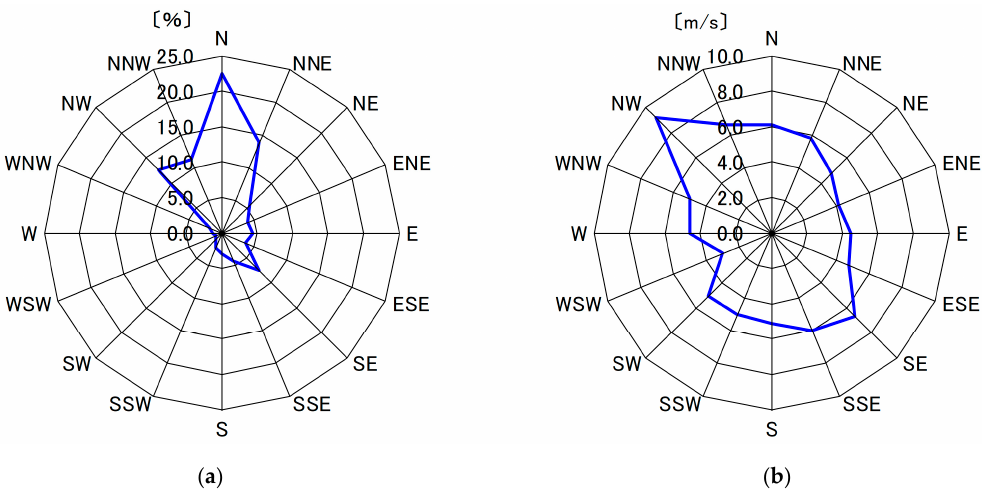
Figure 9. Frequency distribution of the direction of the 10-minute average wind (%): ( a ) wind rose (frequency distribution) and the average of the 10-minute average wind speed observed for 16 wind directions (m/s): ( b ) wind speed by direction (wind measurement height: hub height (60 m), analysis period: November 3, 2015, 0:00 a.m. JST–March 17, 2016, 7:00 a.m. JST). Table 4. Frequency distribution of the direction of the 10-minute average wind (%) and the average of the 10-minute average wind speed observed for 16 directions (wind measurement height: hub height (60 m), analysis period: November 3, 2015, 0:00 a.m. JST–March 17, 2016, 7:00 a.m. JST). Height Item